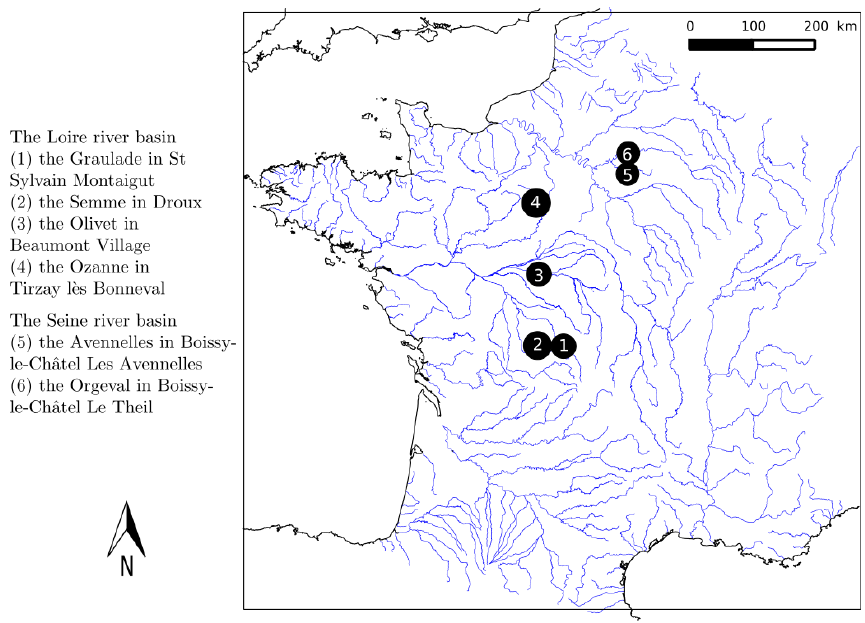
Figure 2. The locations of the study reaches in France. Table 2. Characteristics of the six reaches and their catchment. The bankfull width w bf is taken from the study of Navratil et al. (2006), and the average width w m and the standard deviation σ(w) are calculated for minimum discharge Q min